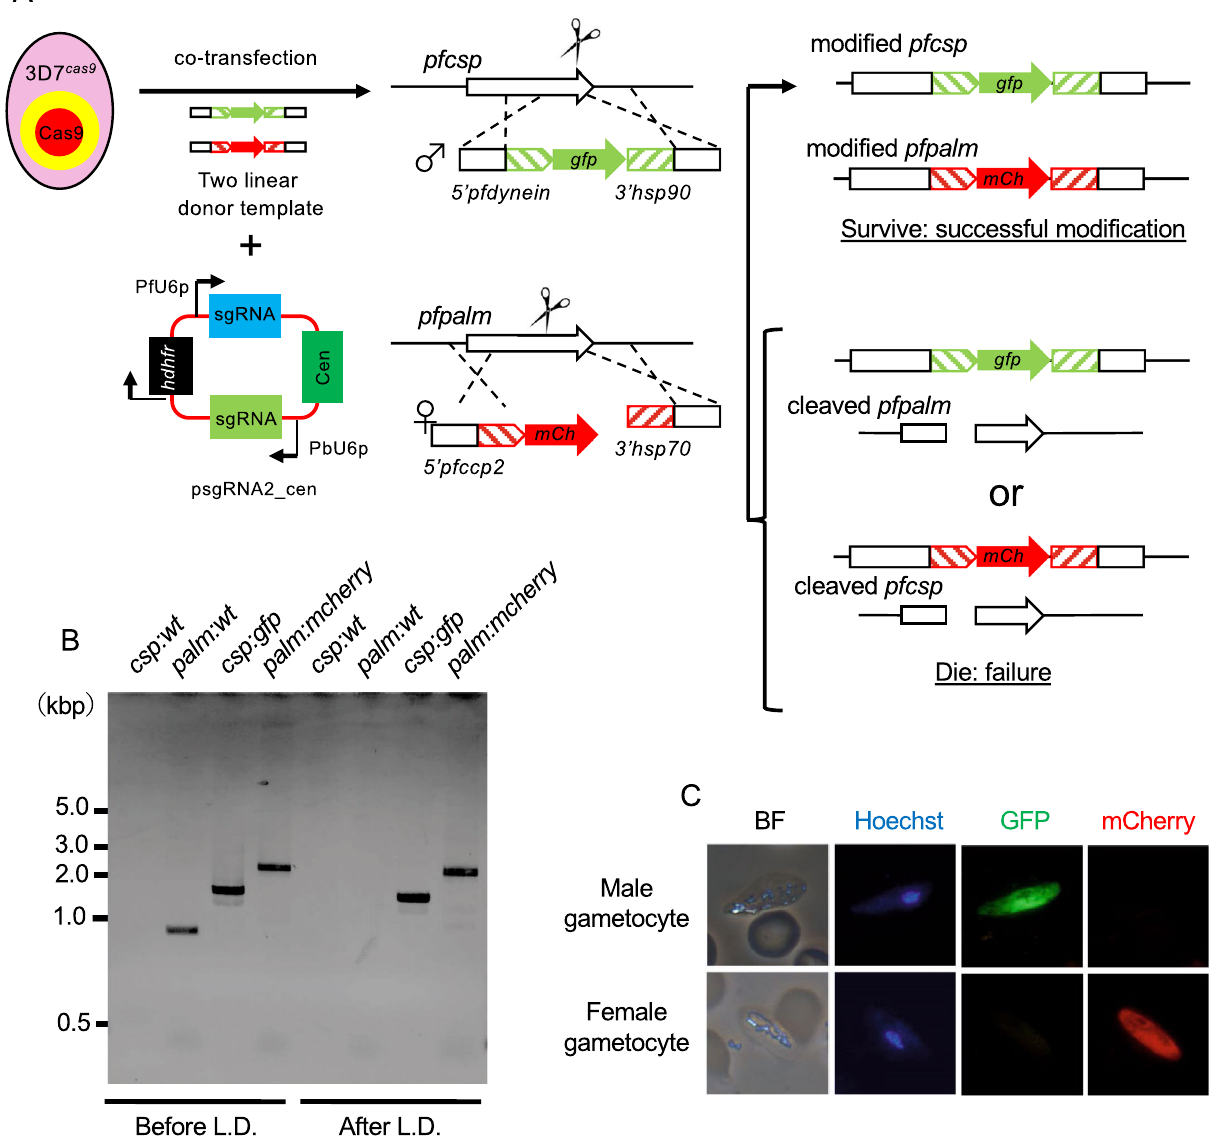
Figure 4. Generation of a reporter parasite line of sexual parasites by double genetic engineering. ( A ) Two linear donor templates, which contained male- and female-specific reporter cassettes, and the psgRNA2_cen plasmid containing two sgRNAs were co-introduced into 3D7 cas9 parasites. A male-specific reporter cassette with the gfp gene was integrated at the pfcsp locus. A female-specific cassette with the mCherry gene was performed at the pfpalm locus. If the cleaved genomic loci at pfcsp and pfpalm were repaired with donor templates by HDR, the parasite would survive. However, if one of them was not repaired, parasites would die due to instability of the cleaved chromosome. ( B ) Genotyping PCR was performed using genomic DNA purified from 3D7 cas9-Pfg_red/green before and after limiting dilution. The primers used for this analysis are shown in Supplementary data 1. Full length gel image is included in Fig. S4G. ( C ) GFP and mCherry were expressed in male and female gametocytes of 3D7 cas9-Pfg_red/green , mCherry, into two genomic loci on different chromosomes; the GFP and mCherry expression cassettes were integrated into the pfcsp gene on chromosome 3 and the pfpalm gene on chromosome 6, respectively. Moreover, the gfp and mcherry genes were transcribed sex-specifically under the control of the promoters of the dynein heavy chain (Male: PF3D7_1023100) and CCP2 (Female: PF3D7_1455800), respectively. The expression cas- settes of GFP and mCherry were flanked with sequences used for HDR by PCR, resulting in each donor template DNA. The gRNAs specific for the pfcsp and pfpalm genes were designed and cloned into the psgRNA2_cen plas- mid, resulting in psgRNA2_cen_csp:palm. The psgRNA2_cen_csp:palm plasmid and the two donor templates containing GFP and mCherry expression cassettes were co-introduced into the 3D7 cas9 parasites. Transgenic parasites were harvested after becoming visible in the culture 14 days after transfection. PCR-based genotype analysis indicated that the GFP cassette was integrated into the genomic locus of the pfcsp gene with almost